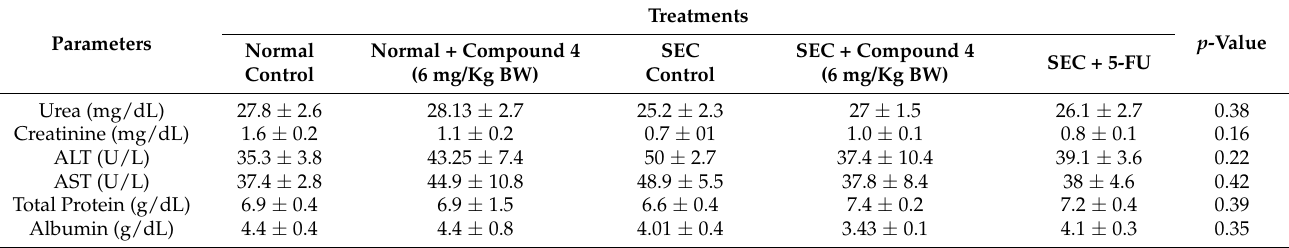
Table 3. Effects of compound 4 and 5-FU treatments on the biochemical parameters of SEC-bearing